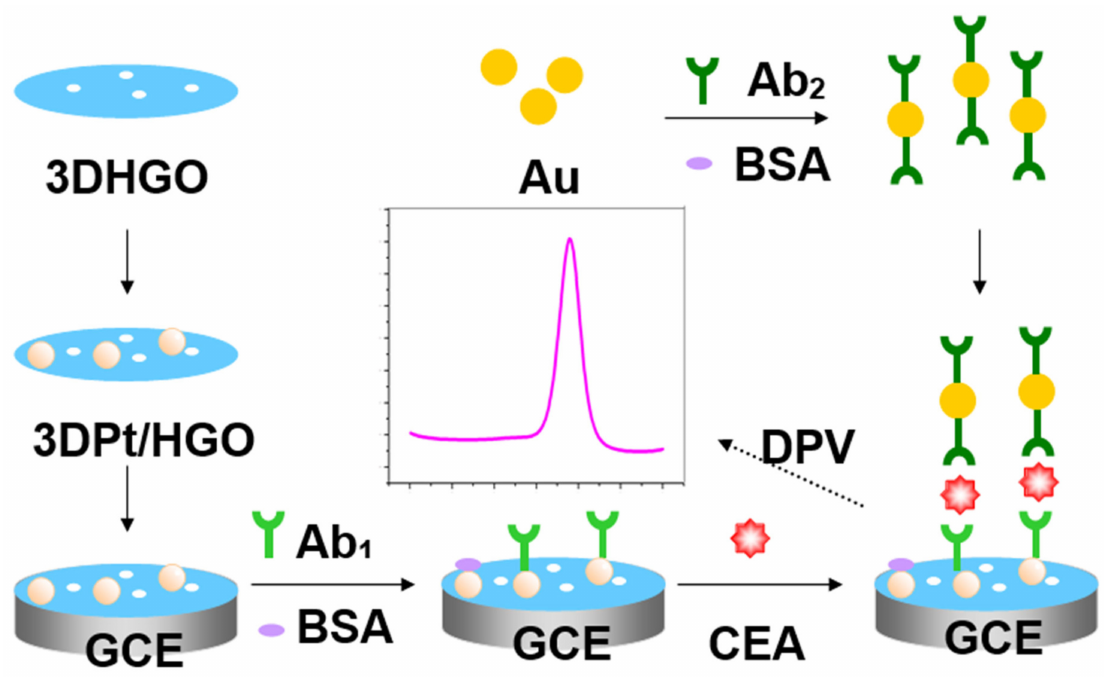
Figure 1. The schematic illustration of the fabrication process of the carcinoembryonic antigen (CEA) immunosensor. Ab 1 : capture antibody; Ab 2 : secondary antibody; 3DPt / HGO: 3D porous graphene-oxide-supported platinum metal nanoparticles; GCE: glass carbon